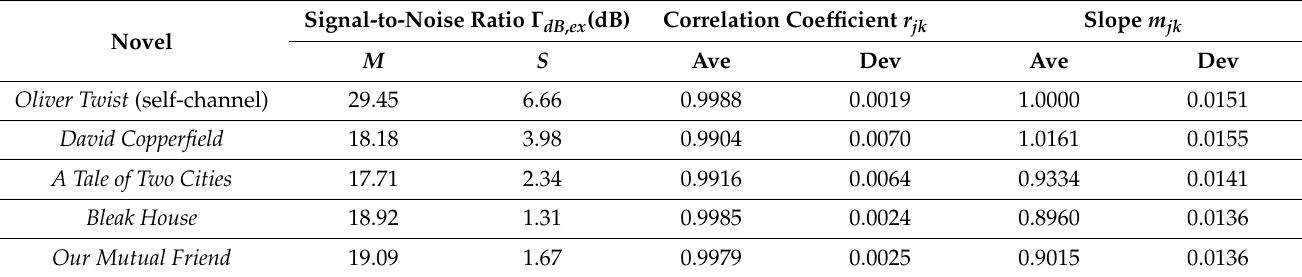
Table 5. Average value M (dB) and standard deviation S (dB) of Γ dB , ex (dB) in self- and cross-channels, average value and standard deviation of correlation coefficient r jk , and slope m jk of the regression line between the number of sentences n S of Oliver Twist (channel output) versus the number of sentences n S in the other Dickens novels (channel input), for equal number of words, in the sentences channel. Four decimal digits are reported because some values differ only from the third digit.